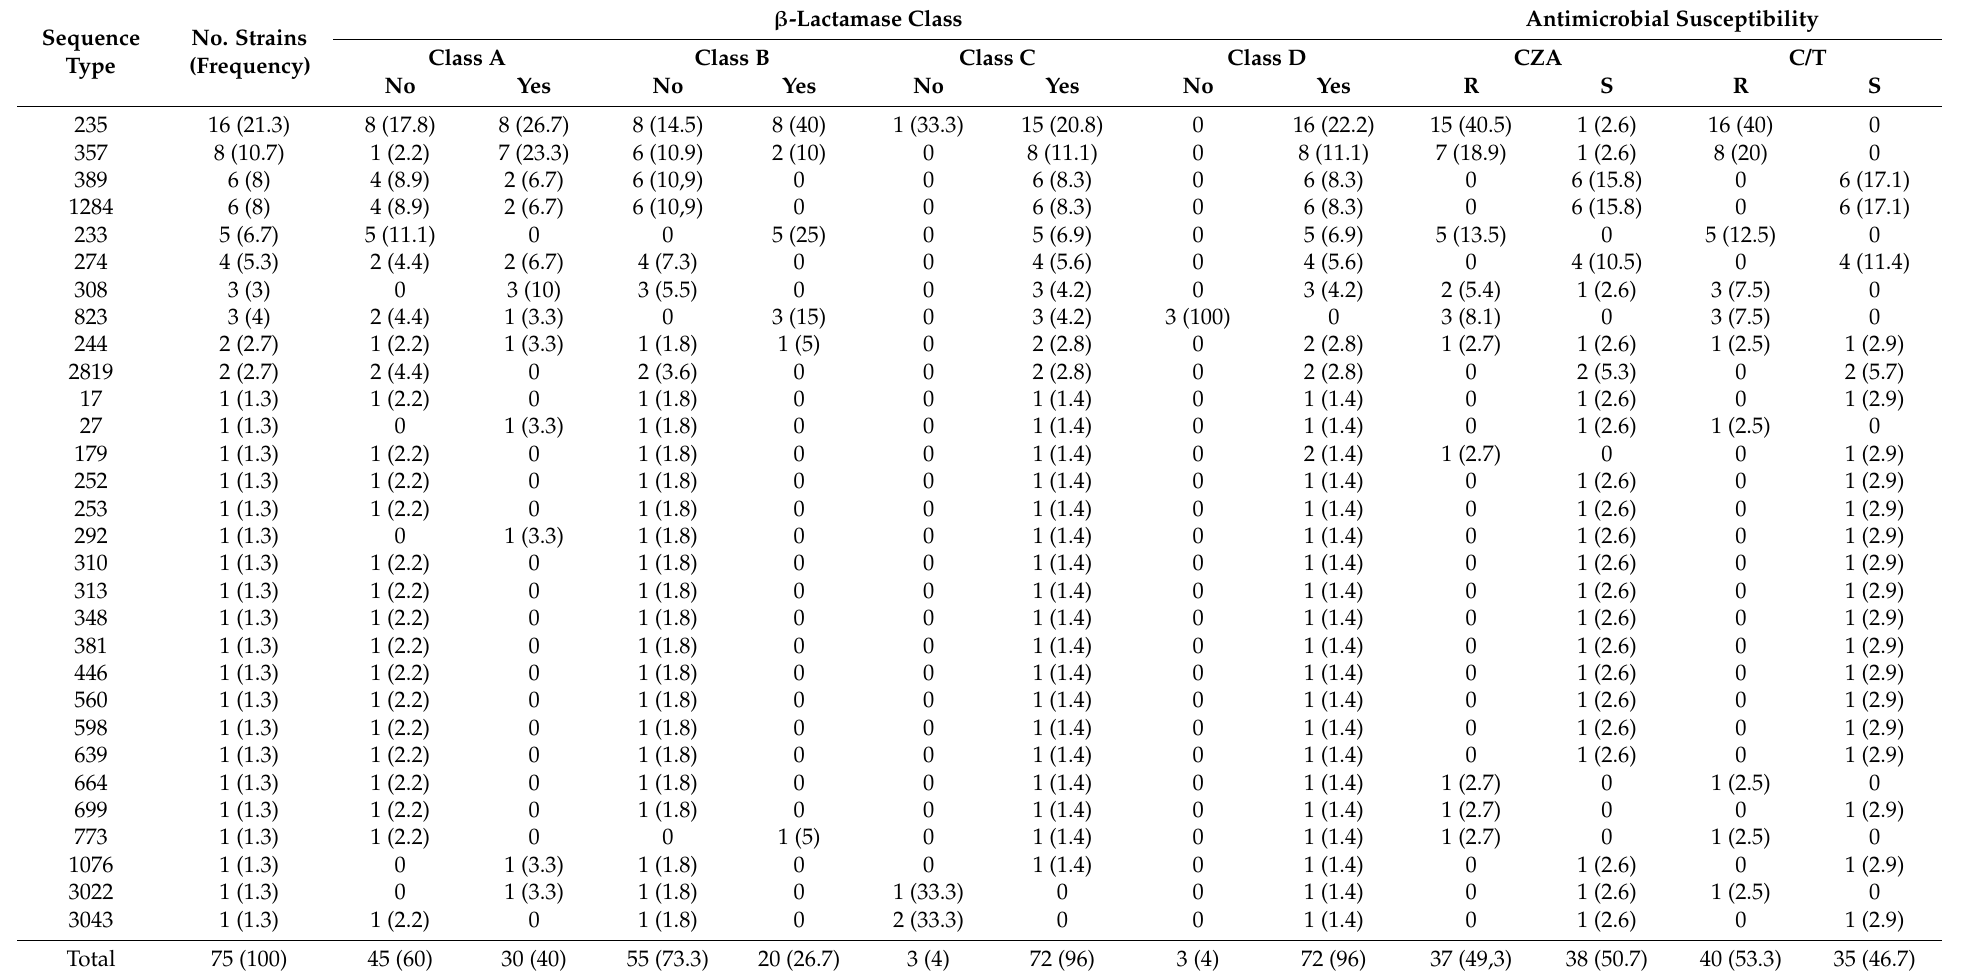
Table 1. The frequency of MDR- P. aeruginosa sequence types associated with β -lactamase classes are categorized according to the Ambler classification and